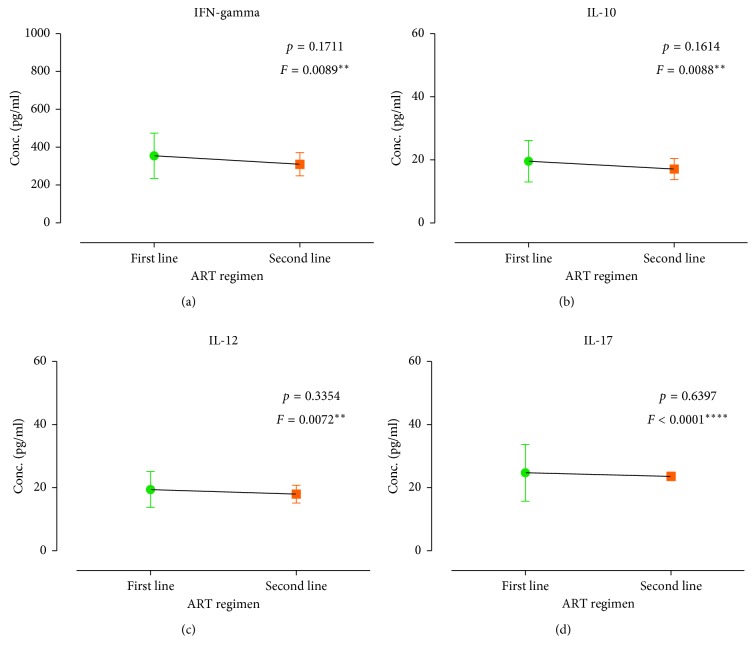
Cytokine distribution of the study participants according to the ART regimen: (a) IFN-gamma, (b) IL-10, (c) IL-12, and (d) IL-17.